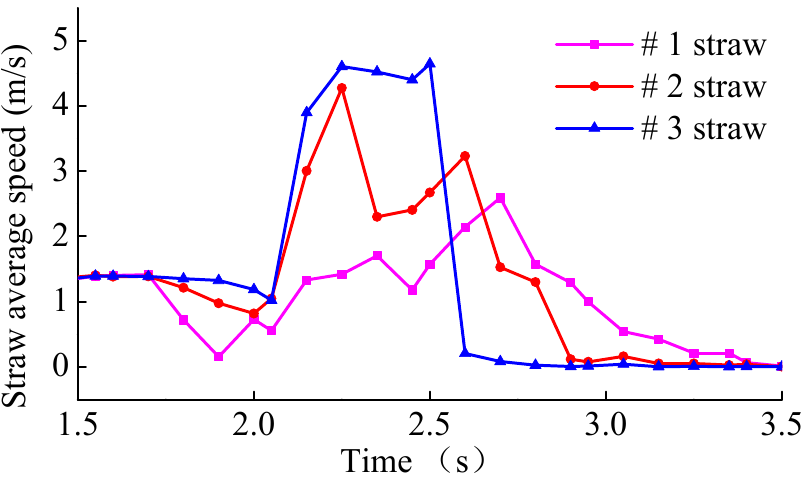
Figure 10. Straw average speed change.